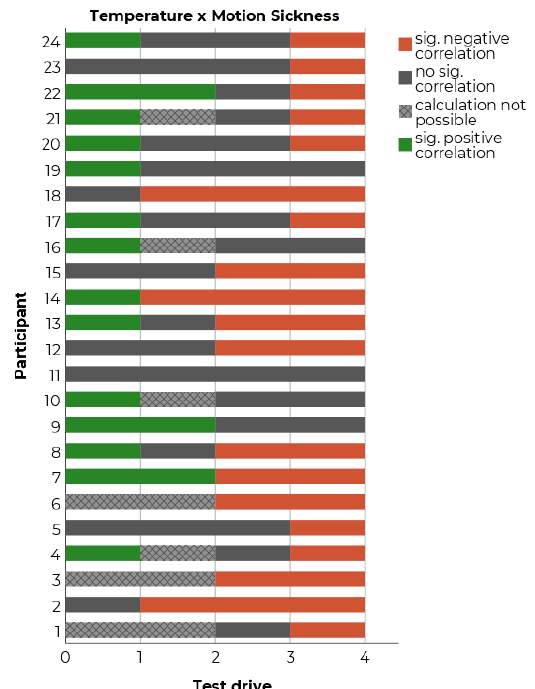
Figure 5. Count of significant Spearman correlations between temperature and motion sickness for each test drive and each participant.